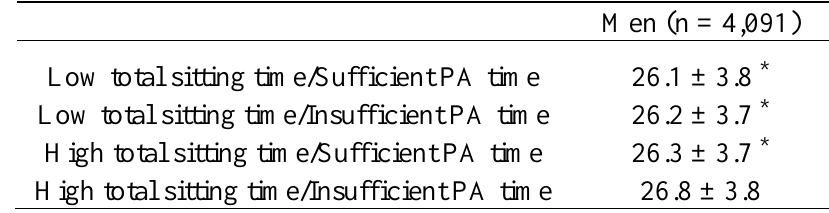
Table 2. Mean (±SD) body mass index (kg/m 2 ) by combined categories of total sitting time and total physical activity time.